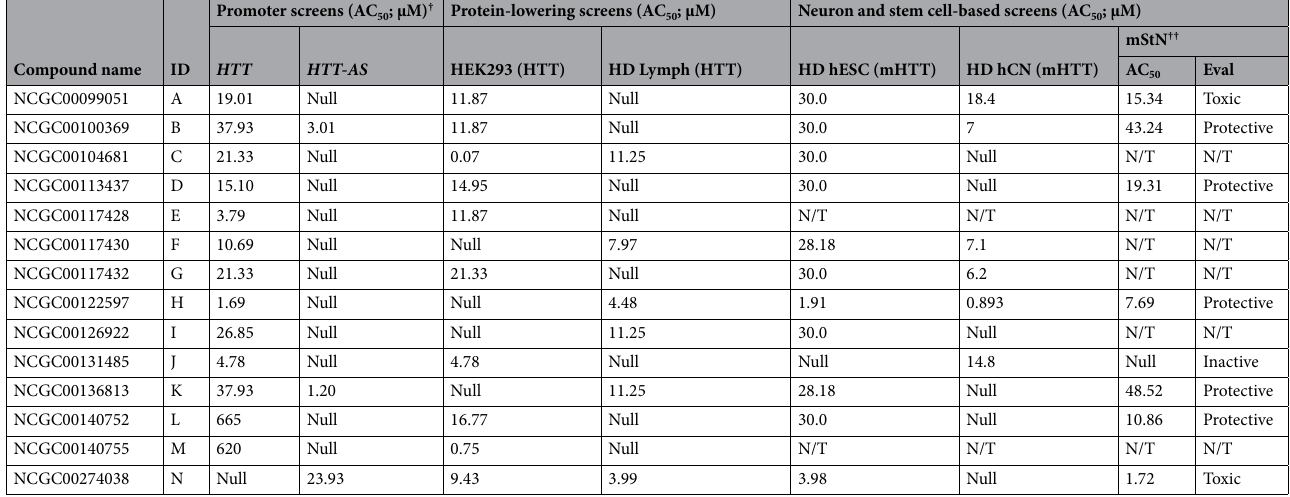
Table 4. Summary of compounds that showed huntingtin protein-lowering activity in the HEK293 and HD lymphoblast assays. N/T = Not tested. † AC 50 indicates luminescent suppression ( HTT ) or induction ( HTT-AS ). †† AC 50 indicates cytoprotection or